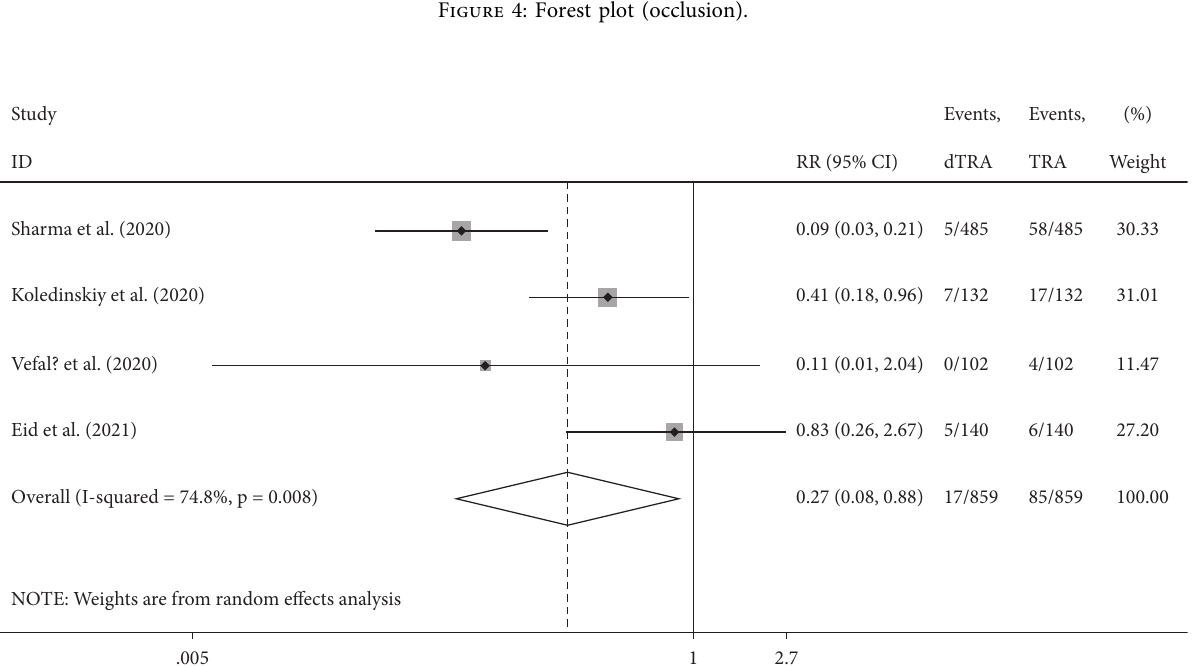
Figure 5: Forest plot (spasm).